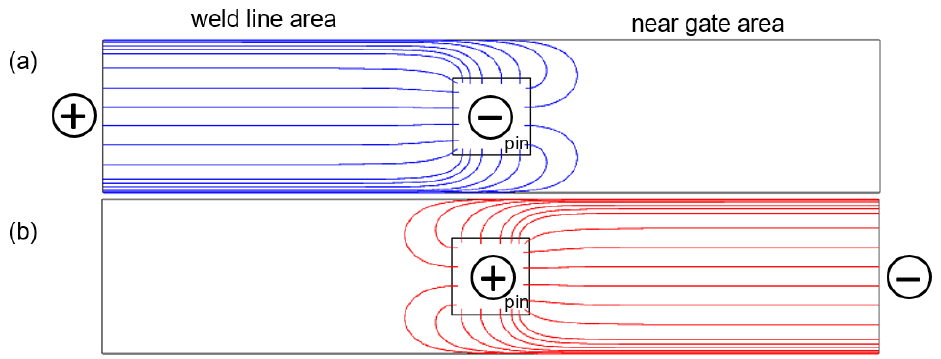
Figure 10. Simplified schematics of the current paths for the measurement of the partial resistances ( a ) R 1 in blue, and ( b ) R 2 in red.